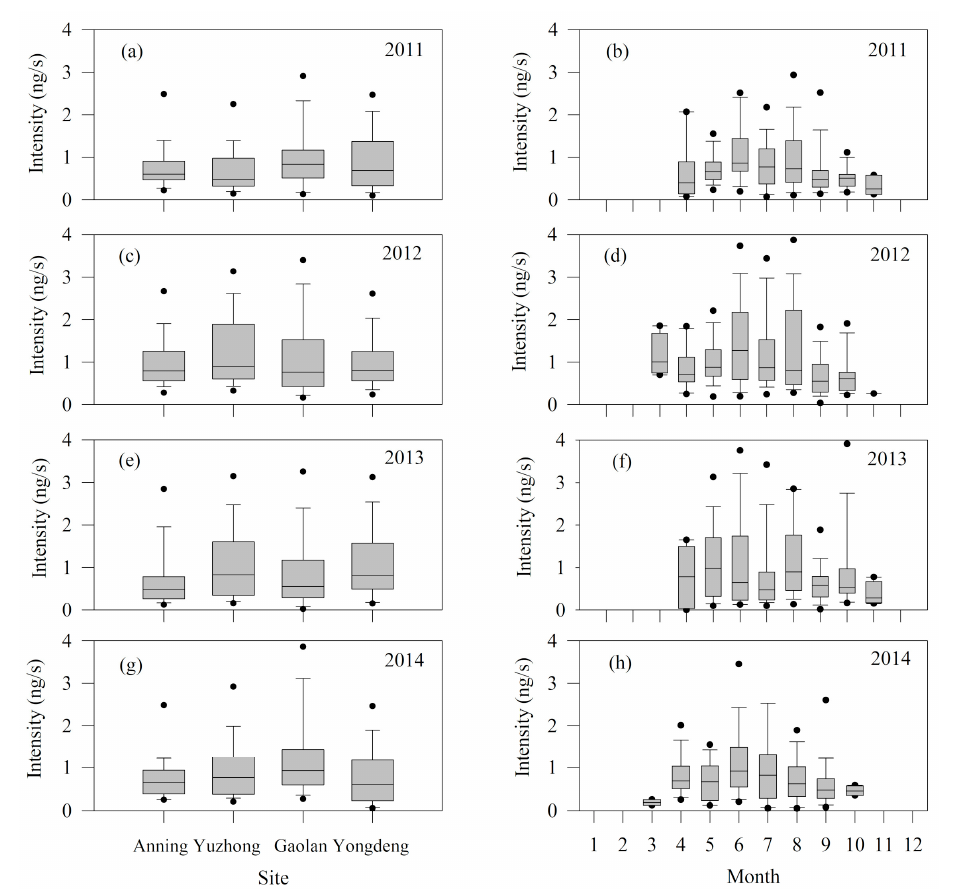
Figure 5. Regional ( a , c , e , g ) and monthly ( b , d , f , h ) variations of raindrop evaporation intensity in 2011 ( a , b ), 2012 ( c , d ), 2013 ( e , f ) and 2014 ( g , h ).